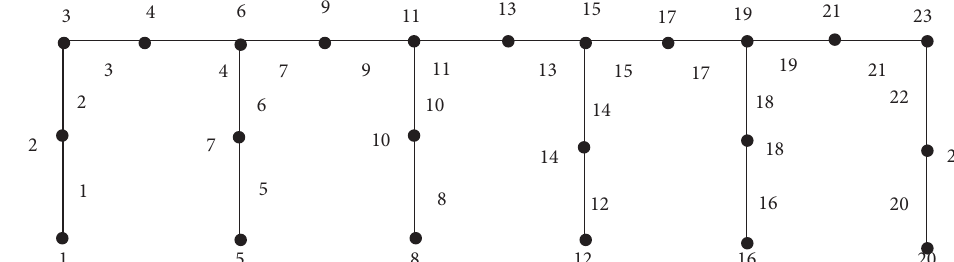
Figure 8: A classical mean labeling of S ( P